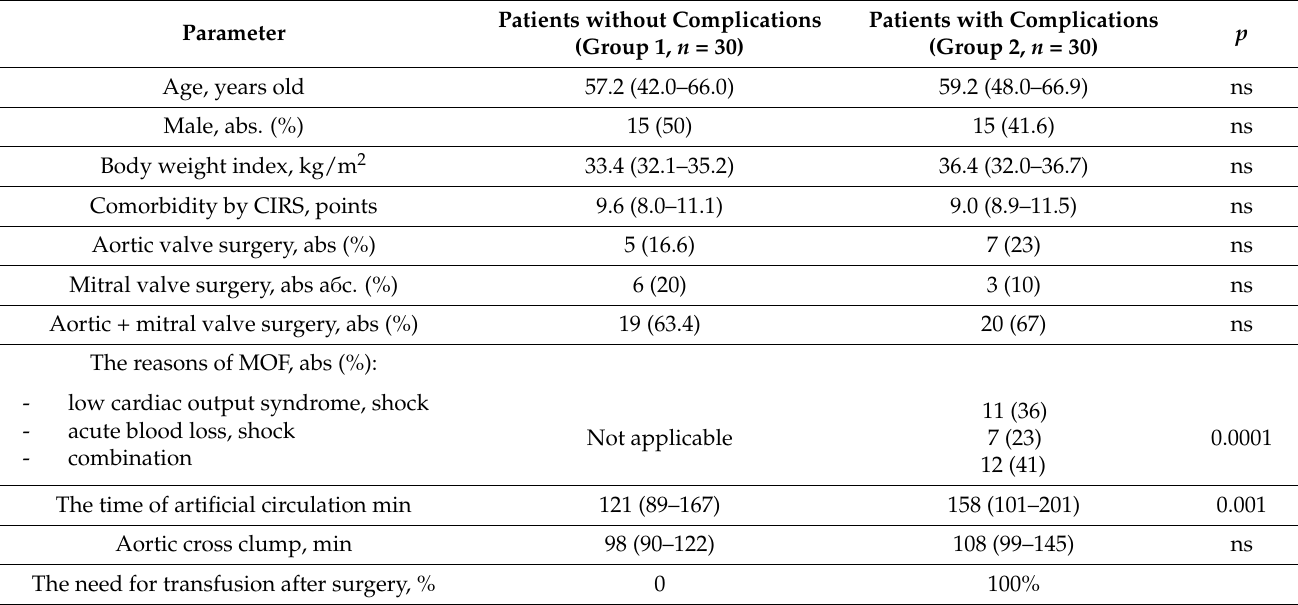
Table 1. Clinical characteristics of